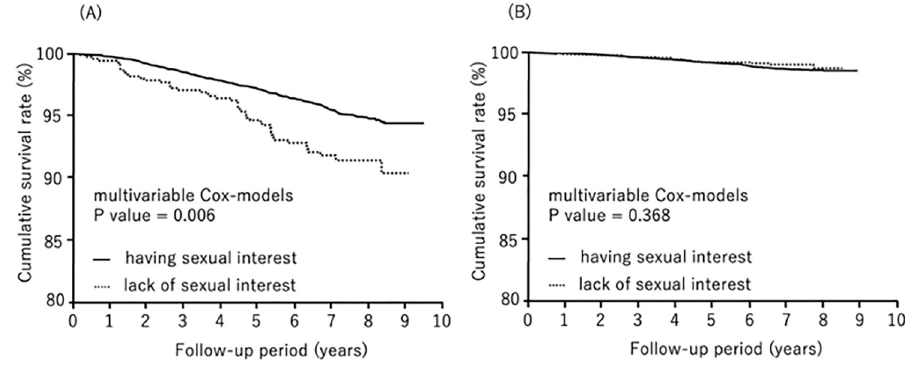
Fig 1. Kaplan-Meier analysis for overall survival by sexual interest. (A) males, (B) females.